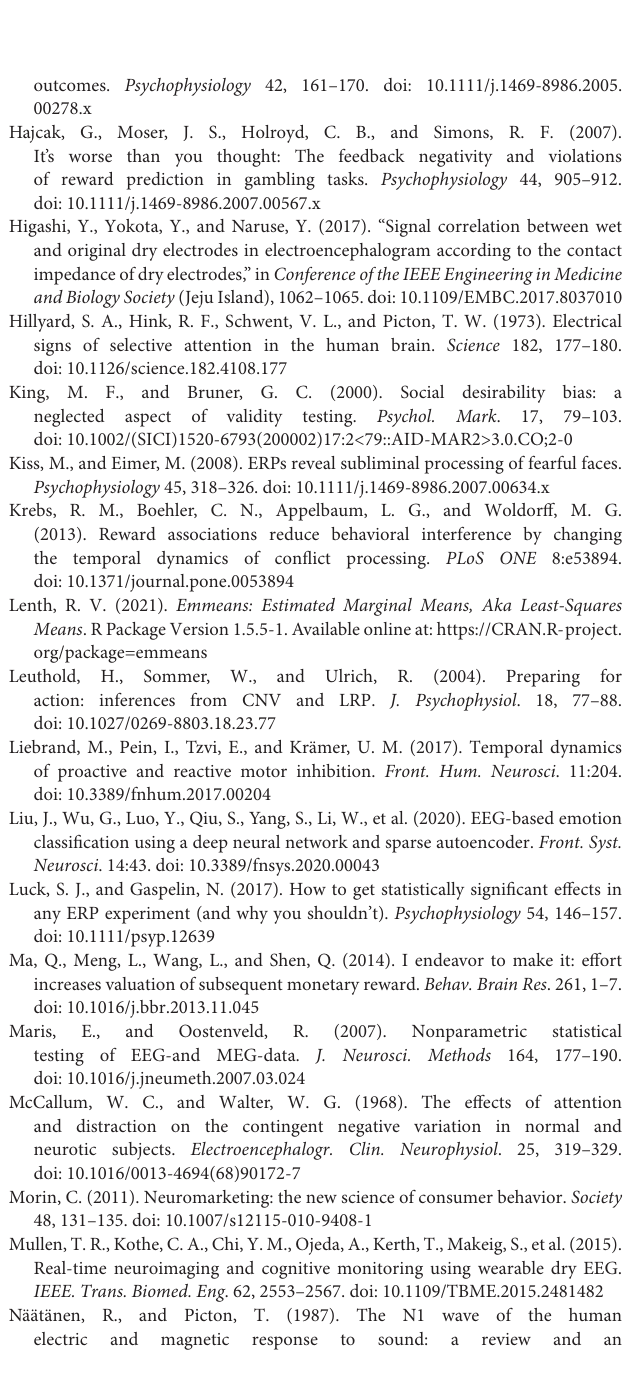
Supplementary Figure 1 | Representative parameters of the mechanical switches related to force required to press the switches and distances to move the switches from free positions